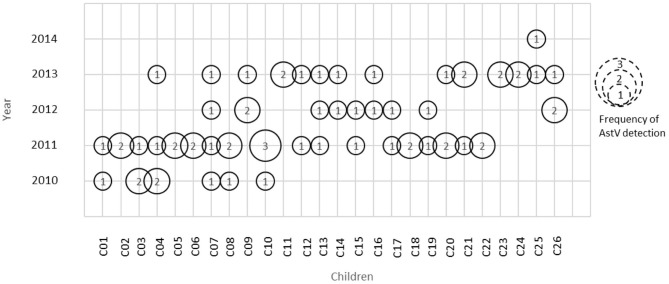
Astrovirus detection in children at different time period. Numbers inside circle represents frequency of astrovirus detection in that particular year.